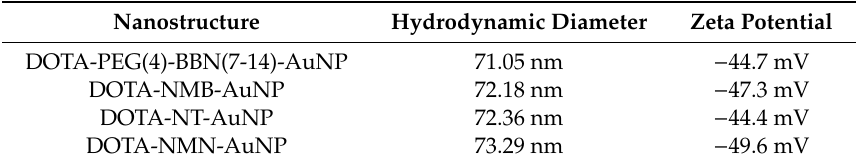
Figure 1. DLS spectra-size distribution by intensity of gold nanoparticles functionalized with peptides: DOTA-NT-AuNP (red), DOTA-NMN-AuNP (black), DOTA-NMB-AuNP (green) and DOTA-PEG(4)-BBN(7-14)-AuNP (blue). Table 2. Nanocarriers physical properties as measured by